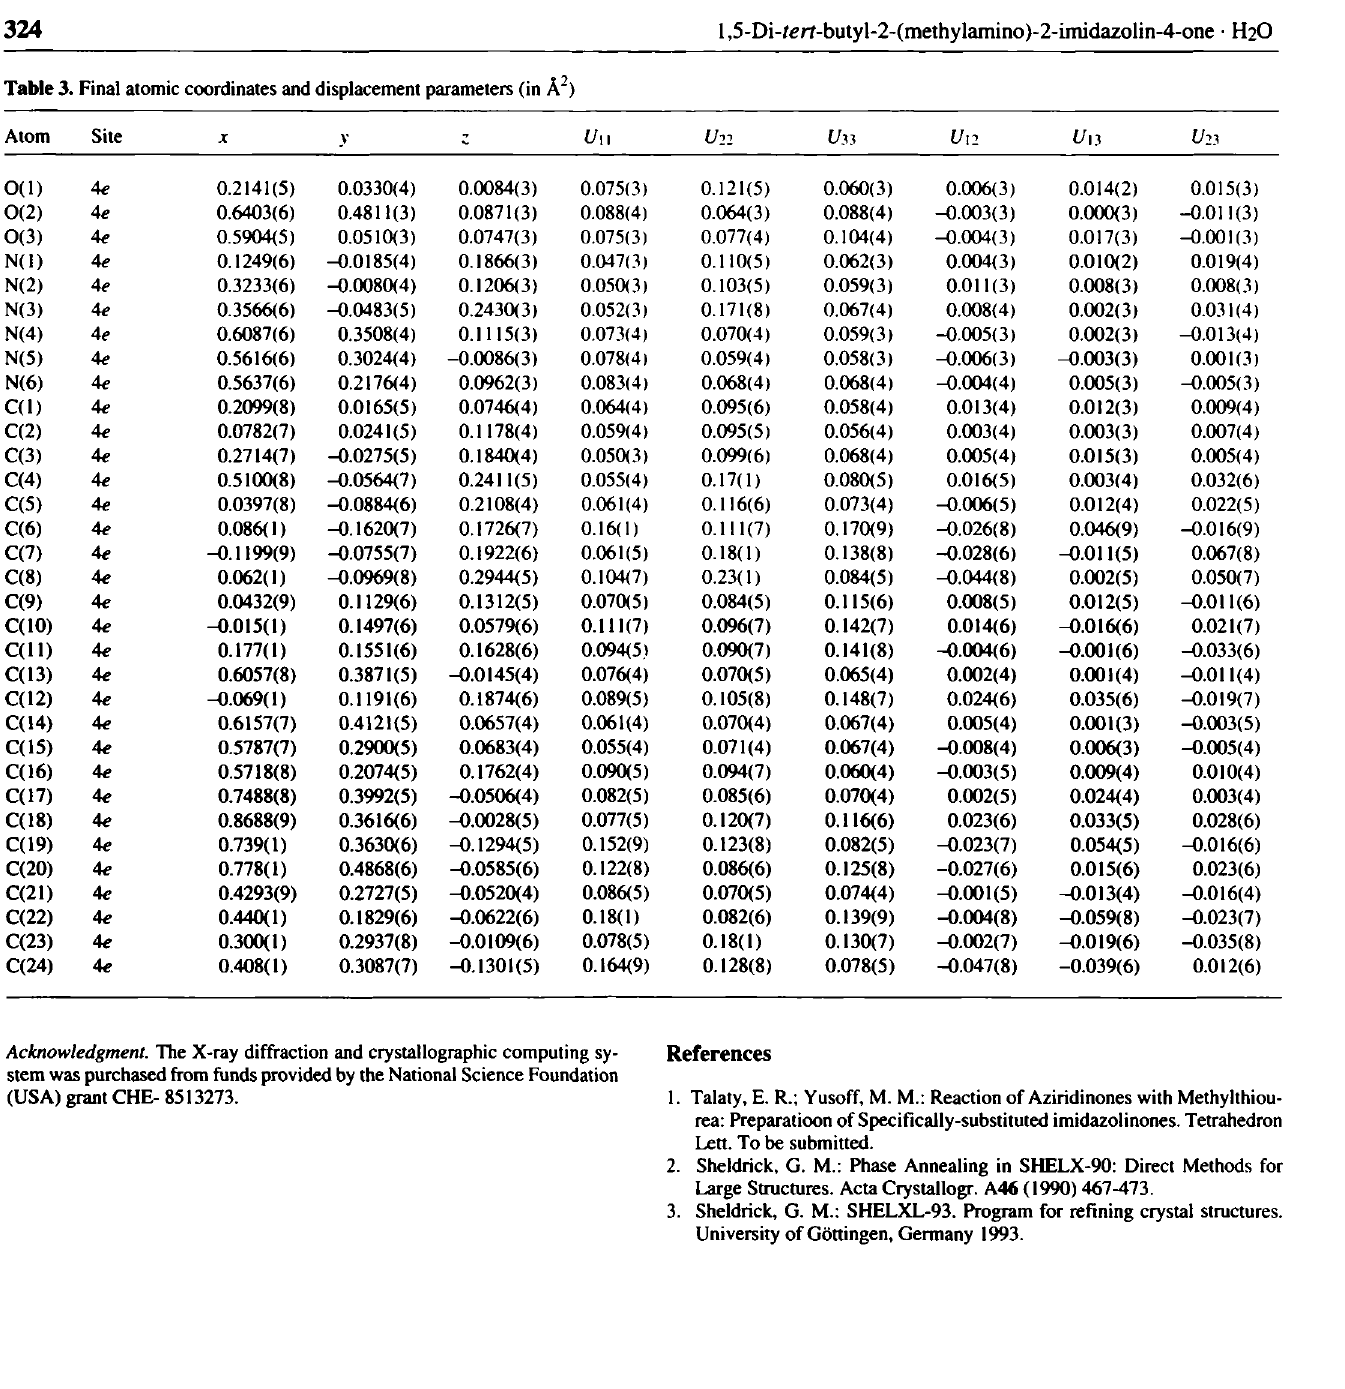
Table 3. Final atomic coordinates and displacement parameters (in Â^) Atom